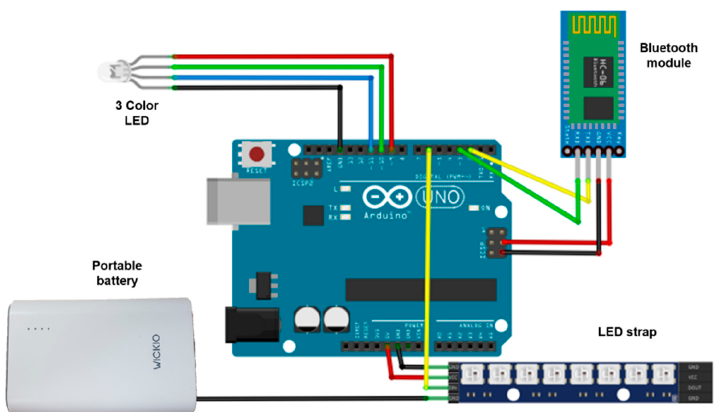
Figure 4. Configuration of circuits connected to the Arduino Uno board.